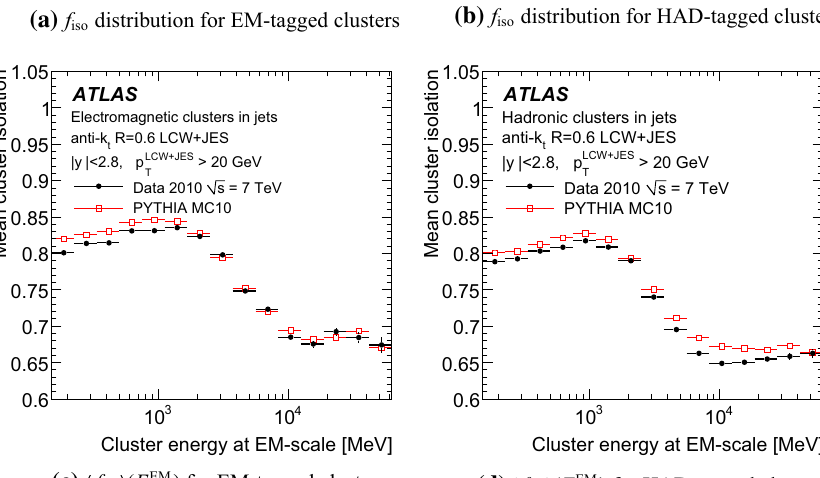
Fig. 16 The distribution of the isolation moment f iso in a clusters classified as electromagnetic, and b clusters classified as hadronic. The average isolation (cid:7) f iso (cid:8) as a function of the cluster signal E EM is shown in c for clus electromagnetic and in d for hadronic topo-clusters. The figures are taken from Ref. [38]